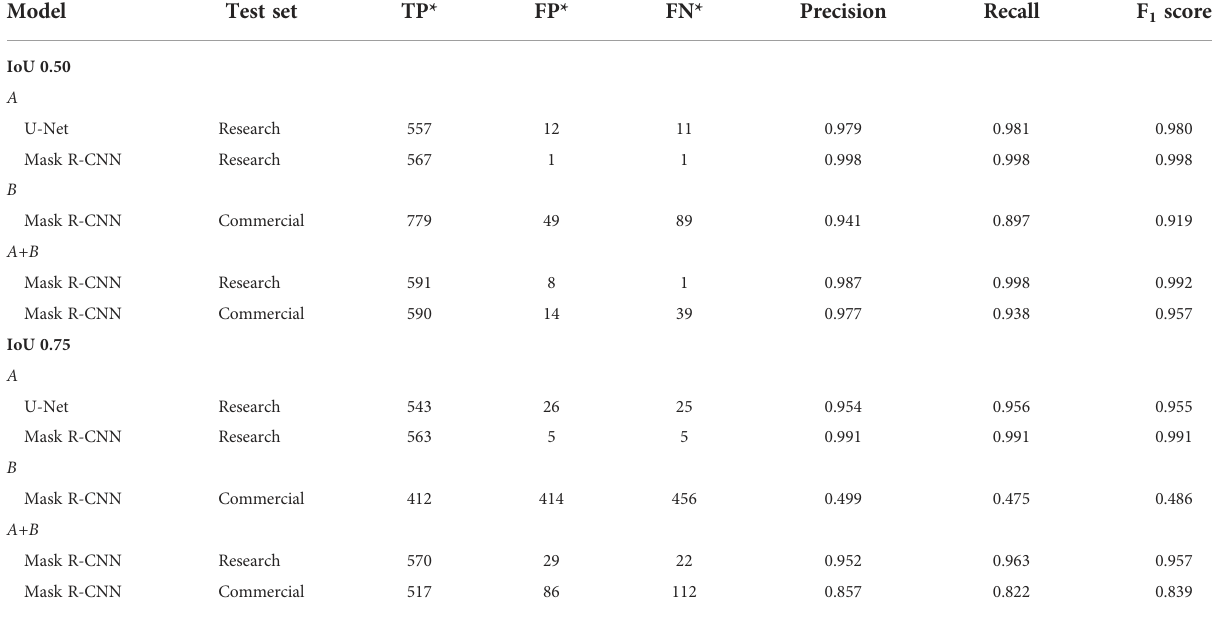
TABLE 2 Segmentation quality at intersection over union (IoU) of 0.50 and 0.75 for all three detection models (A, B, A+B) with the used approach speci fi ed (U-Net or Mask R-CNN) and test set.